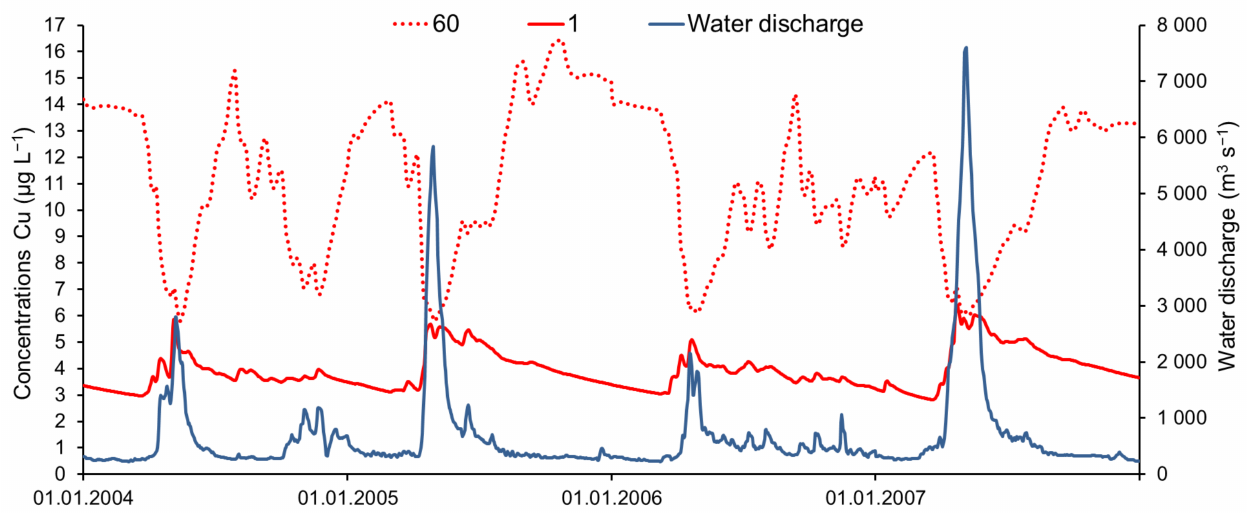
Figure 8. Simulated hydrograph (blue) and dynamics of the copper content in the Belaya River (Ufa city) with the actual content of copper in wastewater (1) and with an increase in the copper content by 60 times (60) over the 2004–2007